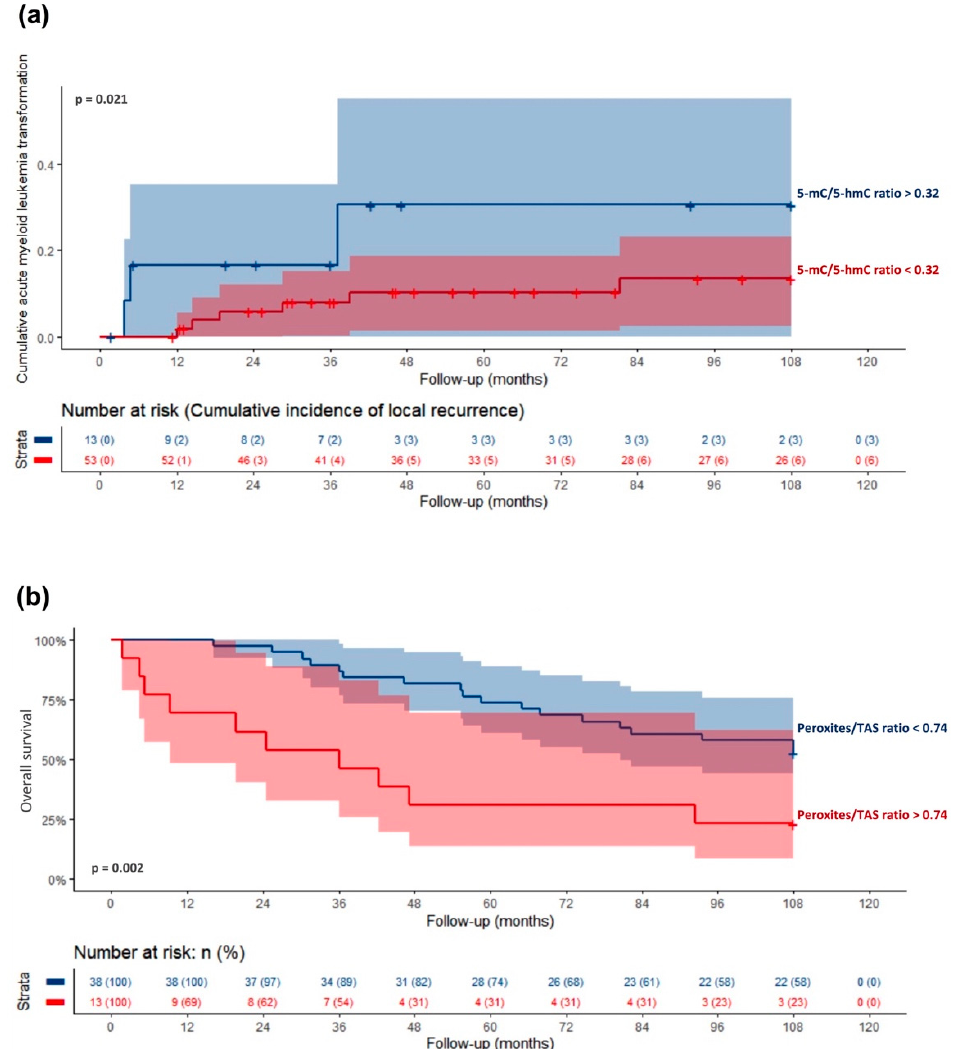
Figure 5. Cumulative acute myeloid leukemia transformation ( a ) and overall survival ( b ) curves of myelodysplastic syndrome patients. MDS patients were stratified through the cut-off points obtained from the ROC curves using a 5-mC/5-hmC ratio for MDS progression and peroxides/TAS ratio for survival.